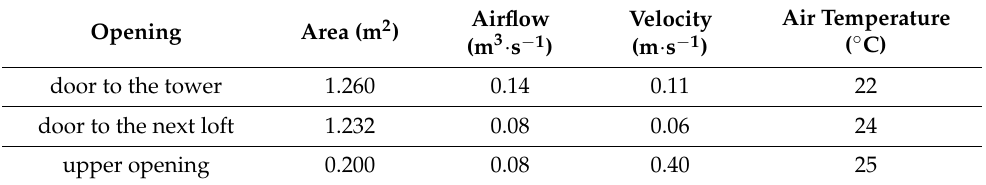
Table 5. Airflow characteristics through the openings at 6:00 p.m. obtained from BPS simulation.